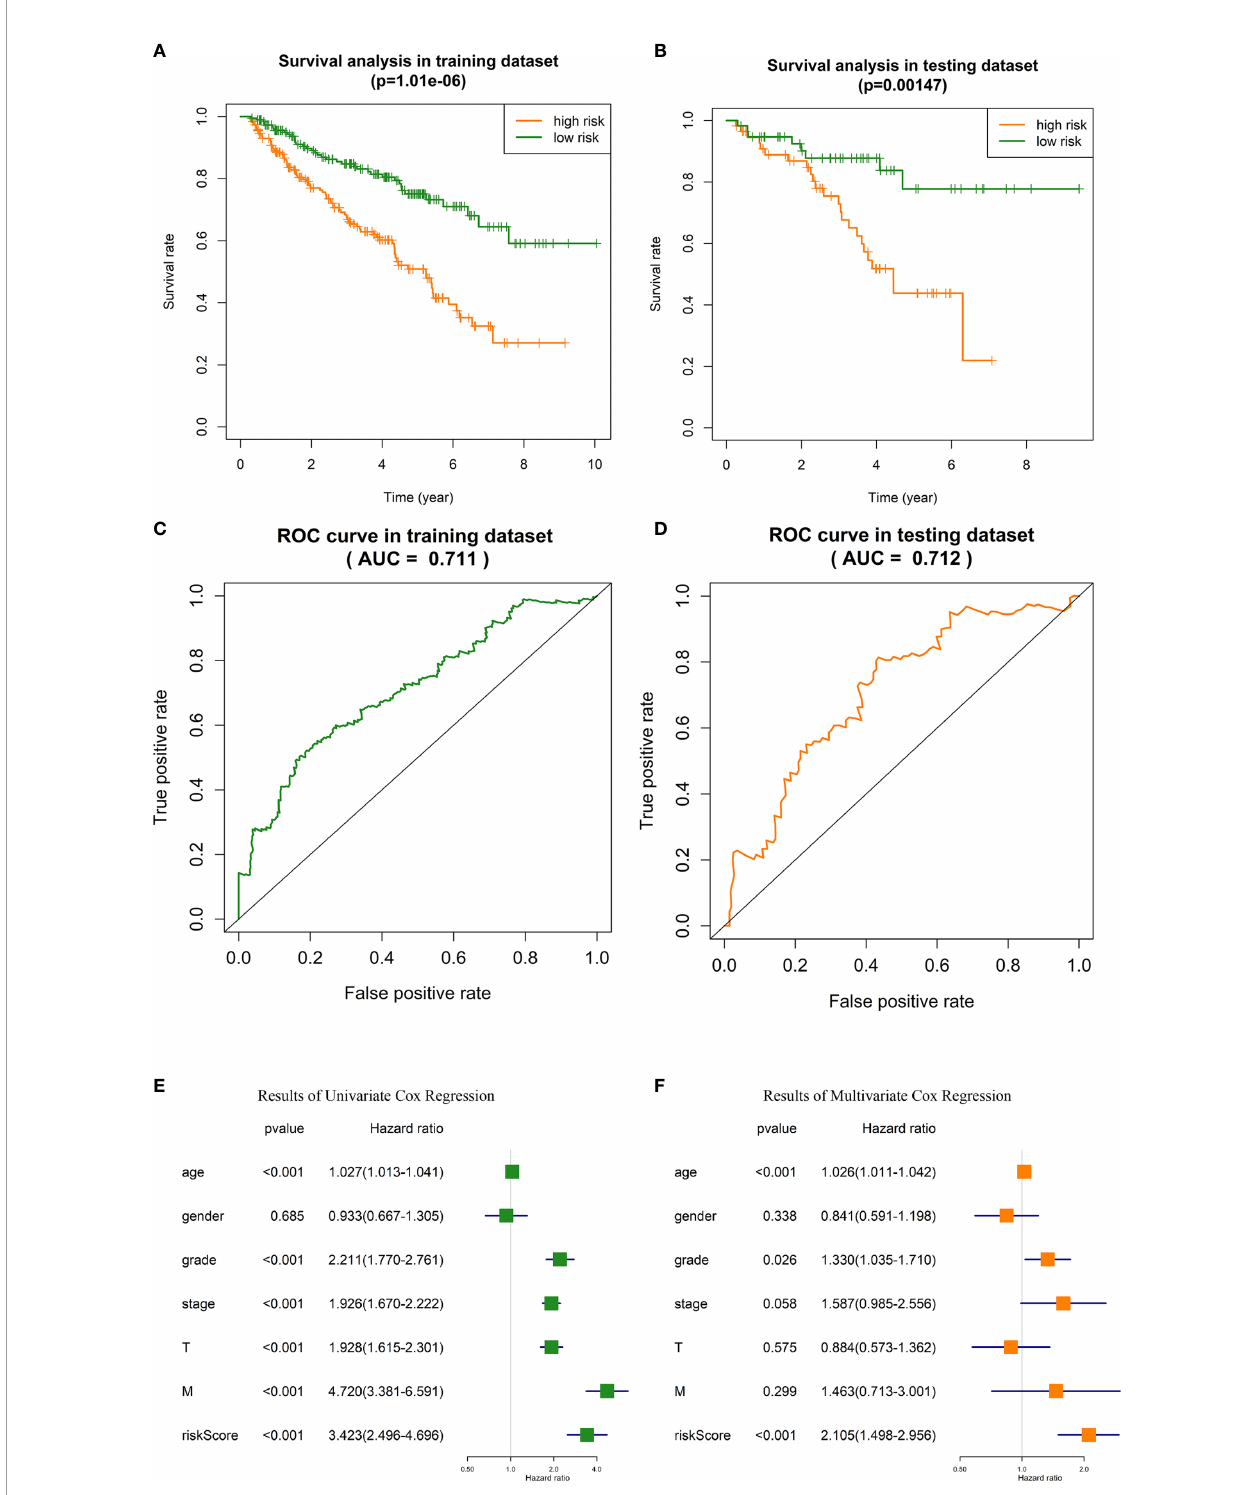
FIGURE 4 | Validation of the GID-lncRNAs based risk signature. (A) Survival analysis in training dataset. (B) Survival analysis in testing dataset. (C) ROC analysis for evaluating the predictive ef fi ciency of the risk signature in the training dataset. (D) ROC analysis for evaluating the predictive ef fi ciency of the risk signature in the testing dataset. (E) Results of Univariate Cox regression. (F) Results of Multivariate Cox